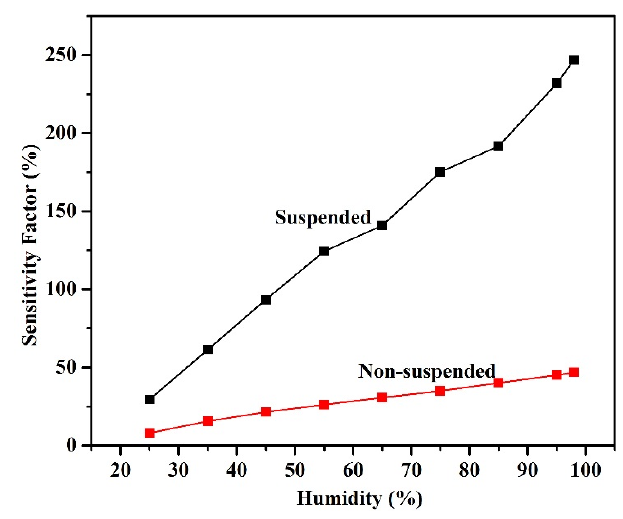
Figure 9. Sensitivities of suspended and non-suspended sensors.